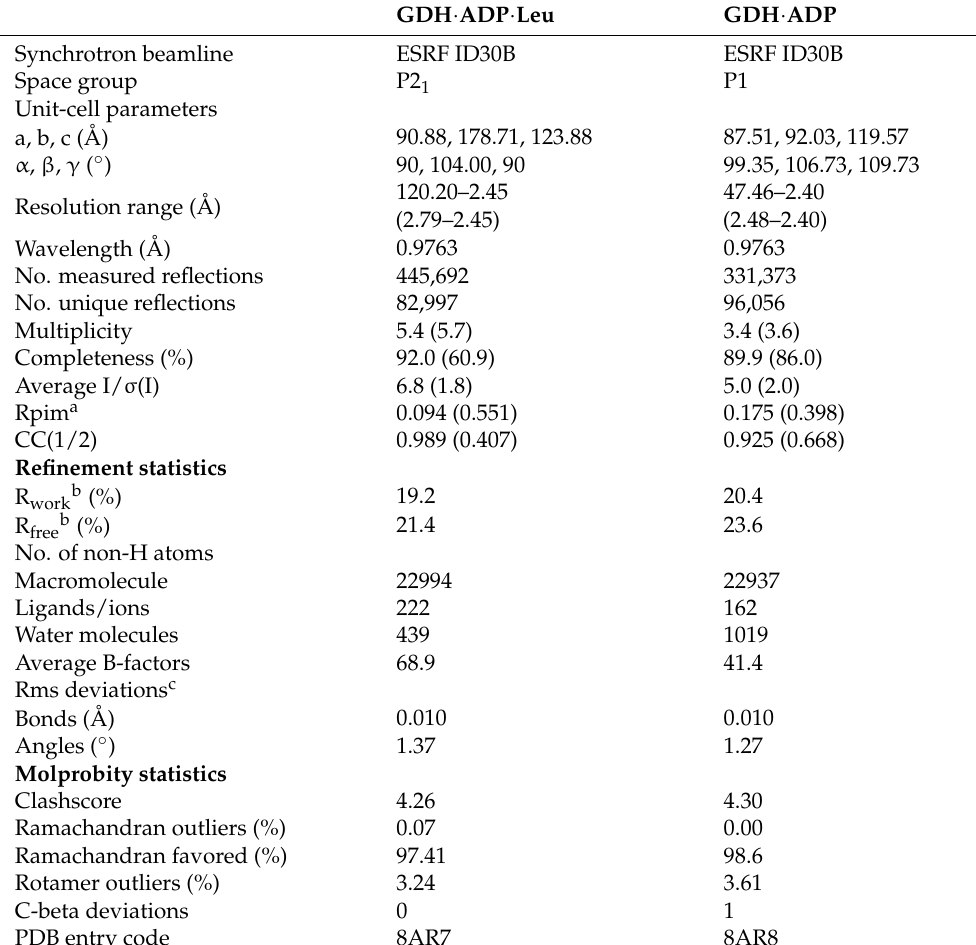
Table 1. Summary of the X-ray